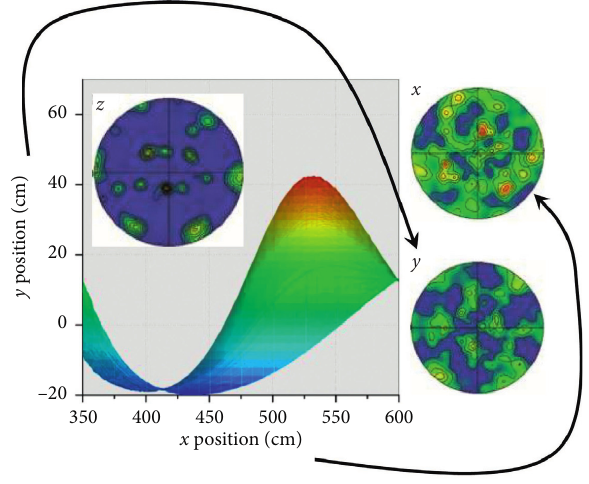
Figure 6: Extraction frame of front view, side view, and top view.